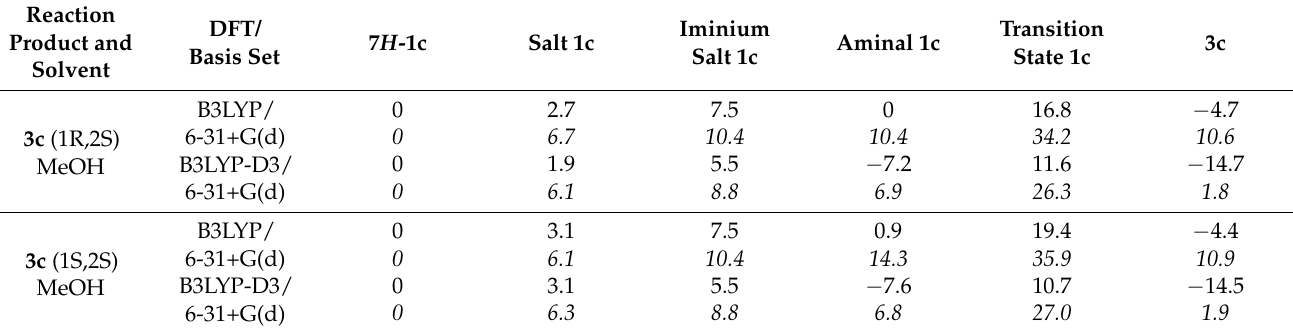
Table 2. The relative electronic (plain text) and Gibbs free (italics) energies (kcal/mol) of subsequent stages of the tandem Mannich—electrophilic amination reactions calculated by B3LYP and B3LYP-D3 methods.